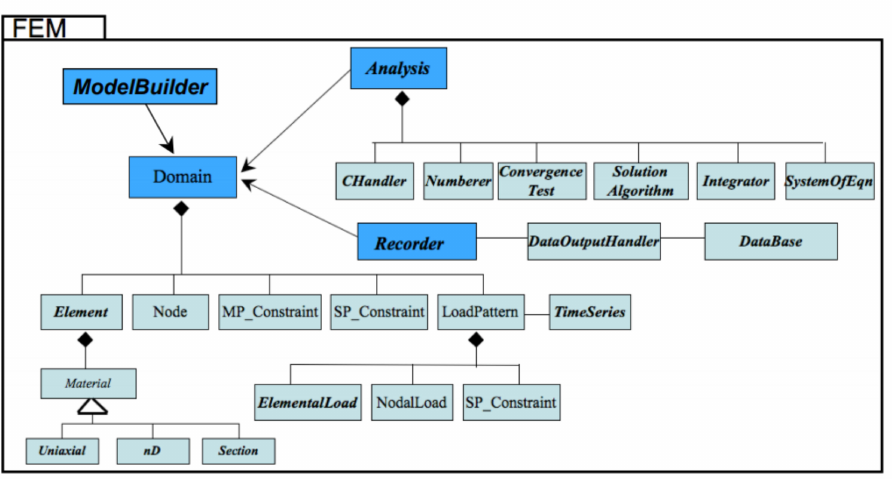
Figure 10. Logical schema of the OpenSees class